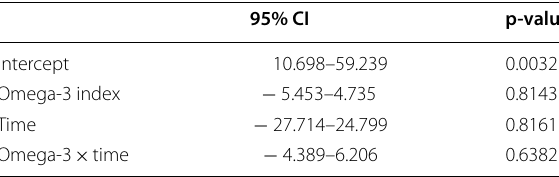
Table 7 Effect of Omega-3 Index on SDNN, unadjusted